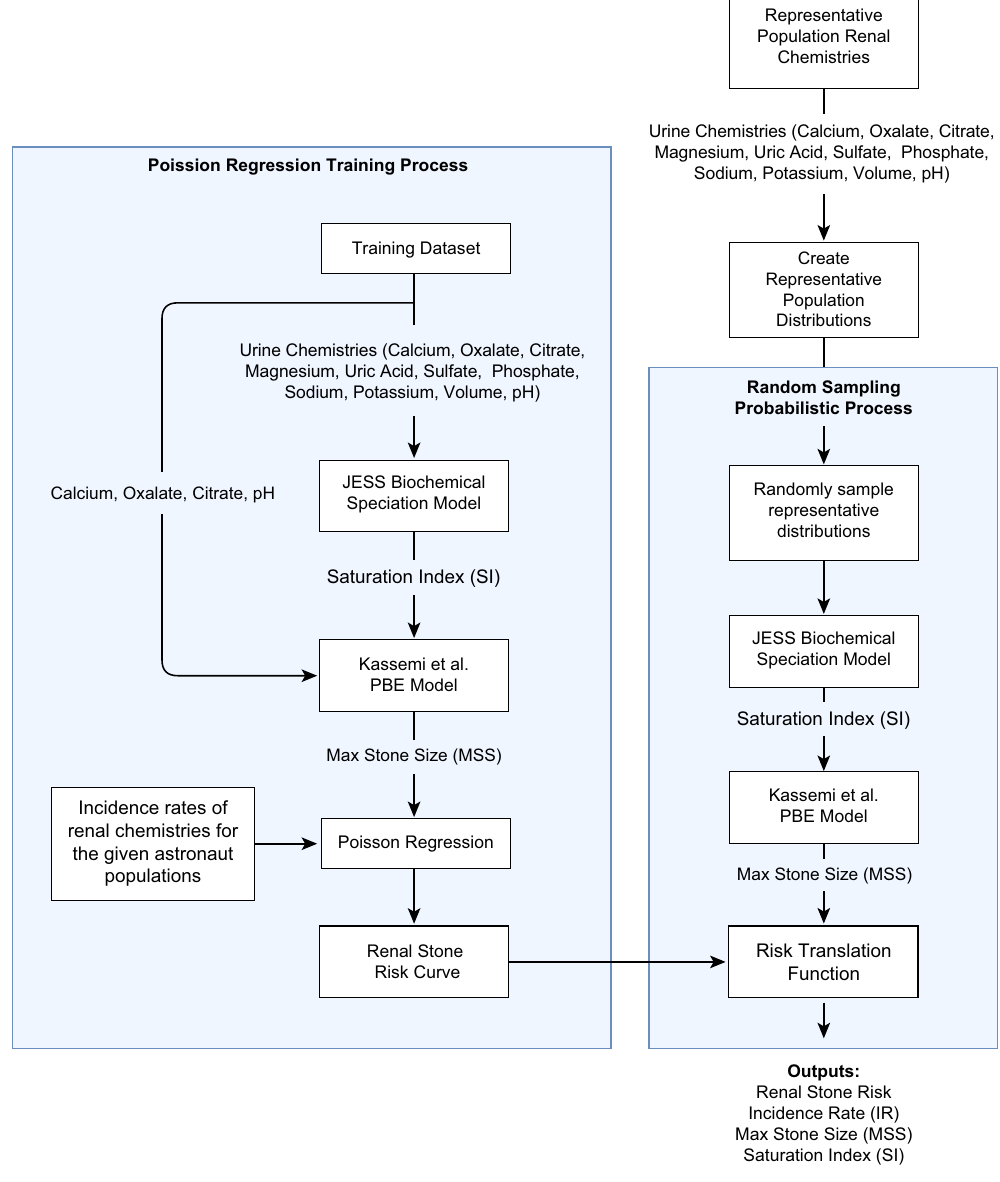
Fig. 7 Illustration of renal stone incidence rate prediction model training and analysis processes. The left-hand side of the fi gure illustrates the use of individualized urine chemistries in sequential calculations of SI and PBE-MSS, known stone-forming characteristics (stone former, non-stone former), space fl ight status characteristics (pre- and post- fl ight), and estimates of the appropriate population incidence distributions (Fig. 1) in order to develop an MSS to IR relation utilizing Poisson regression. The right-hand side of the fi gure illustrates a similar process for the analysis, where representations of urine constituent population statistics are used to generate >10,000 unique urine combinations from which SI, MSS, and IR calculations are combined in a Monte Carlo process to predict the astronaut population